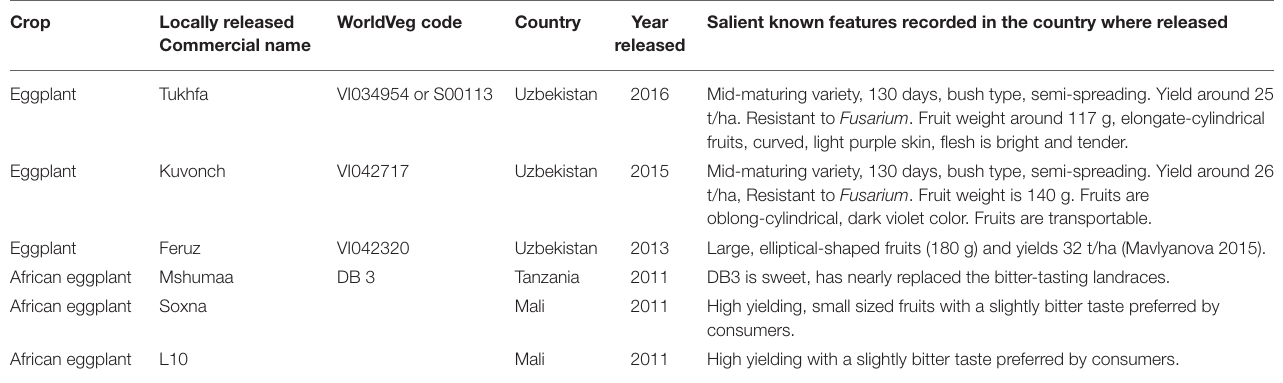
TABLE 4 | List of eggplant and African eggplant varieties released in Uzbekistan, Tanzania, and Mali based on WorldVeg germplasm.